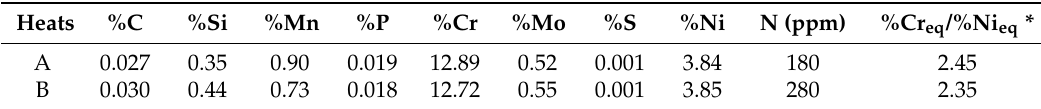
Table 1. Chemical composition of the studied